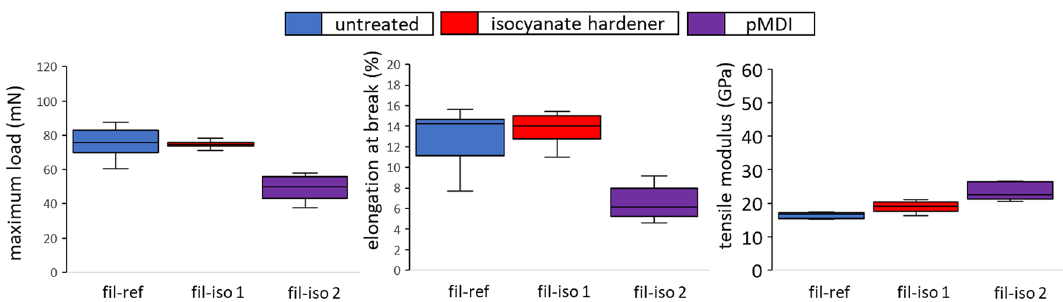
Figure 7. Tensile properties of single viscose filaments without further treatment (fil-ref) and treated with isocyanate hardener for 10 s (fil-iso 1) and 3 days (fil-iso 2),